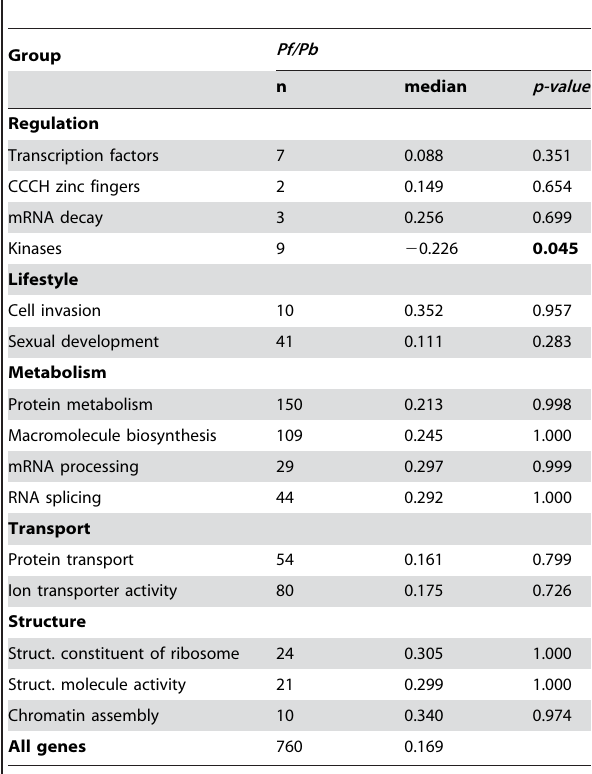
Table 4. Tendency of genes to rank among the most expression-diverged genes with data in both